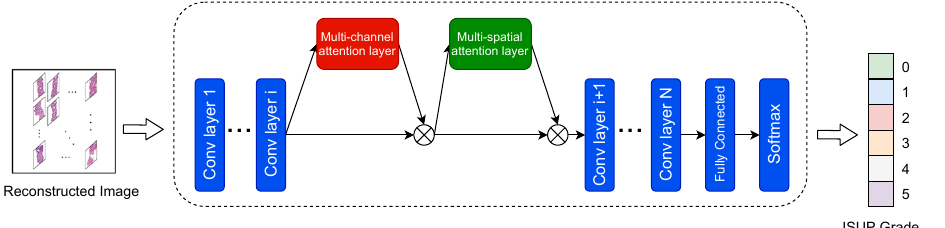
Figure 2. An overview of the MCMS attention-based CNN for whole-slide image classification. We take the preprocessed images with their labels as input to train a CNN with the MCMS module added after a selected convolutional layer to learn channel and spatial attentions. The feature map is refined with the attention information and passes through the network to enhance feature representation. After training, the model is able to quickly zoom in areas of concern and outputs an ISUP